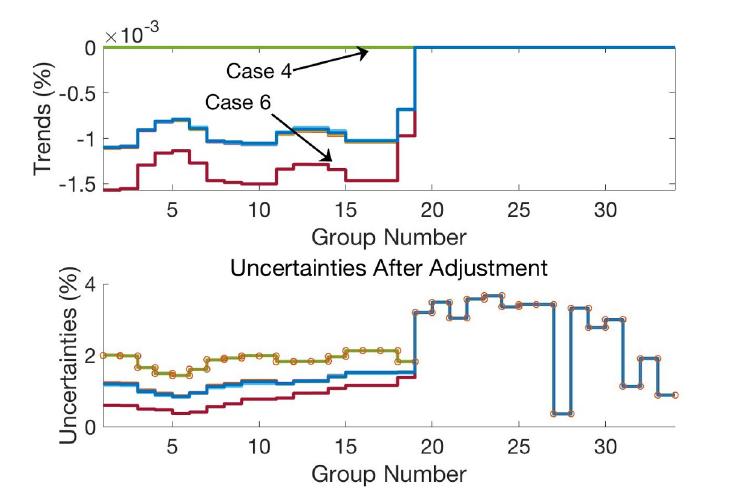
Figure 4. Adjusted Pu239 Fission data (trends and uncertainties) for all 7